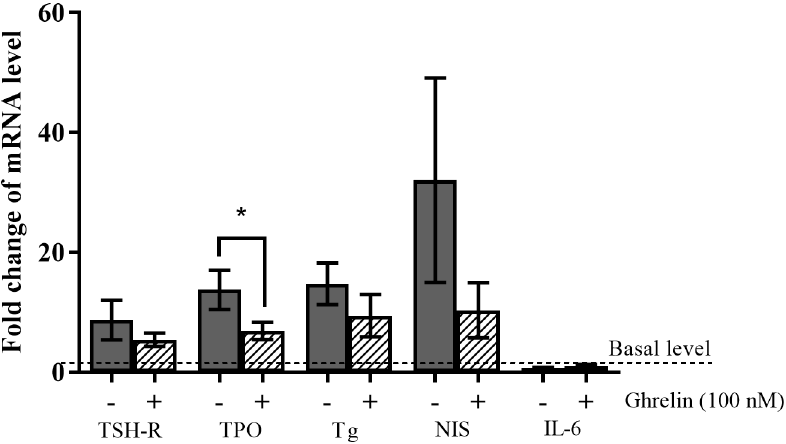
Fig 3. The influence of ghrelin on the thyroid-stimulating hormone (TSH)-induced (0.1 IU/L) mRNA expression of four thyroid components. The expressionof the TSH receptor (TSH-R), thyroperoxidase (TPO), thyroglobulin(Tg) and sodium iodidesymporter (NIS) measured by real-time quantitative polymerase chain reaction (RT-qPCR) in a primary culture of humanthyroid cells in presenceand absenceof ghrelin. Indicatedas fold change of mRNA expressioncomparedto basal level (dashedline). IL-6 was used as a negativecontrol. Grey = vehicle, pattern = ghrelin (100 nM). Means ( ± SEM), n = 6. * P < 0.05 comparedto the control (vehicle). Two patients were excludeddue to unknownsample